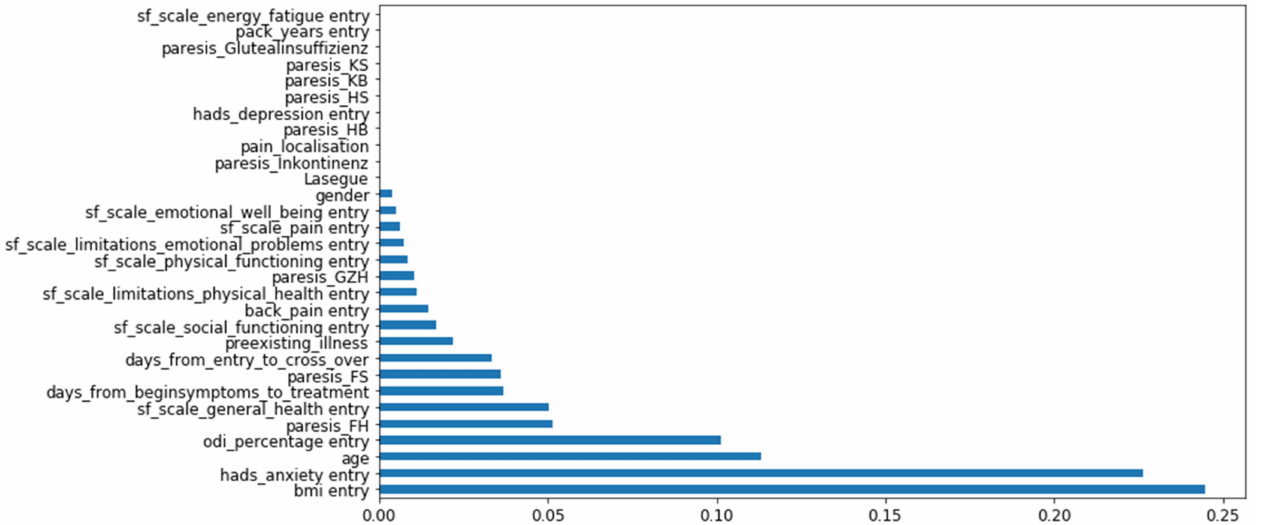
Figure 1. Feature importance shown according to the influence on the prediction values. Greatest influence is depicted with the greatest horizontal bar.